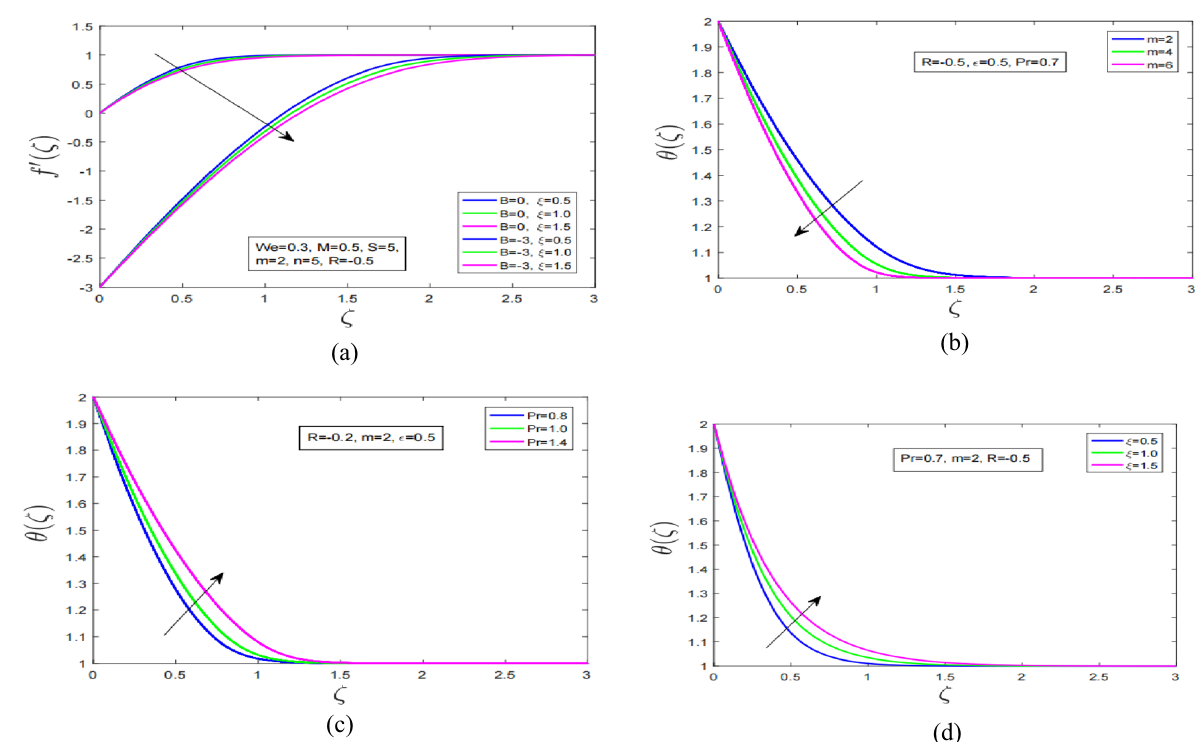
′ . ( b ) Non-linearity impact on θ . ( c ) Prandtl number influence on θ .